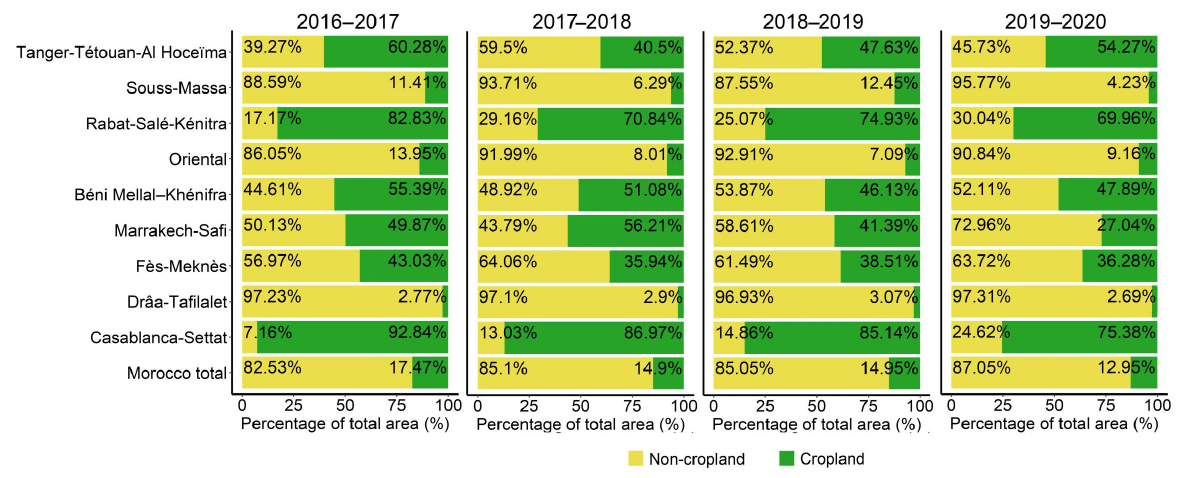
Figure 17. The distribution of cropland and non-cropland areas (%) in this study per different province-level and season over 2016–2020